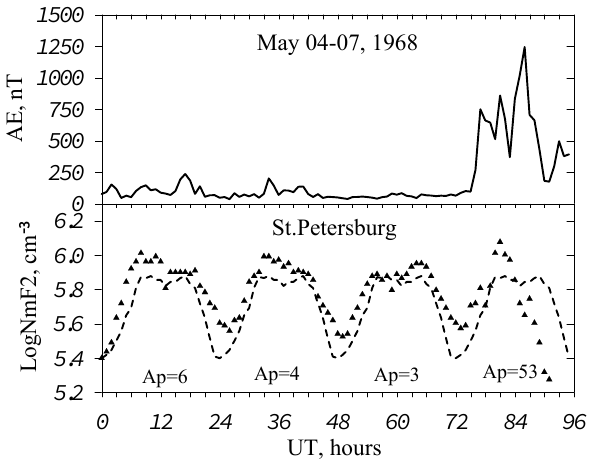
Fig. 3. Fig. 3. A 4-day succession of daytime positive and nighttime nega- tive Nm F2 disturbances under low or slightly elevated auroral activ- ity. Daily A p indices are also given in the lower panel. Note that the pre-storm Nm F2 daytime enhancement on 7 November 1983 looks absolutely the same as for the previous days.